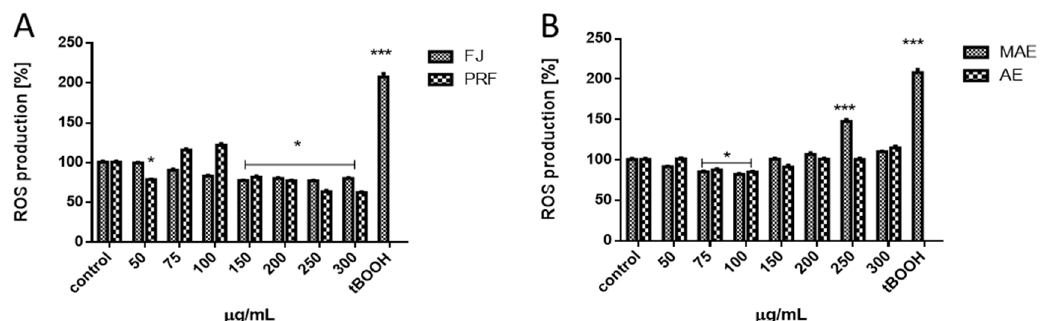
Figure 3. The effect of V. opulus extracts on intracellular ROS generation analyzed by DCFH-DA assay after 24 h incubation with juice (FJ) and PRF (phenolic rich fraction) ( A ), MAE (methanol-acetone extract) and AE (acetone extract) ( B ). Control cells were not exposed to any compound but the vehicle; values are means ± standard deviations from at least three independent experiments; statistical significance was calculated versus control cells (untreated) * p ≤ 0.05, *** p ≤ 0.001.